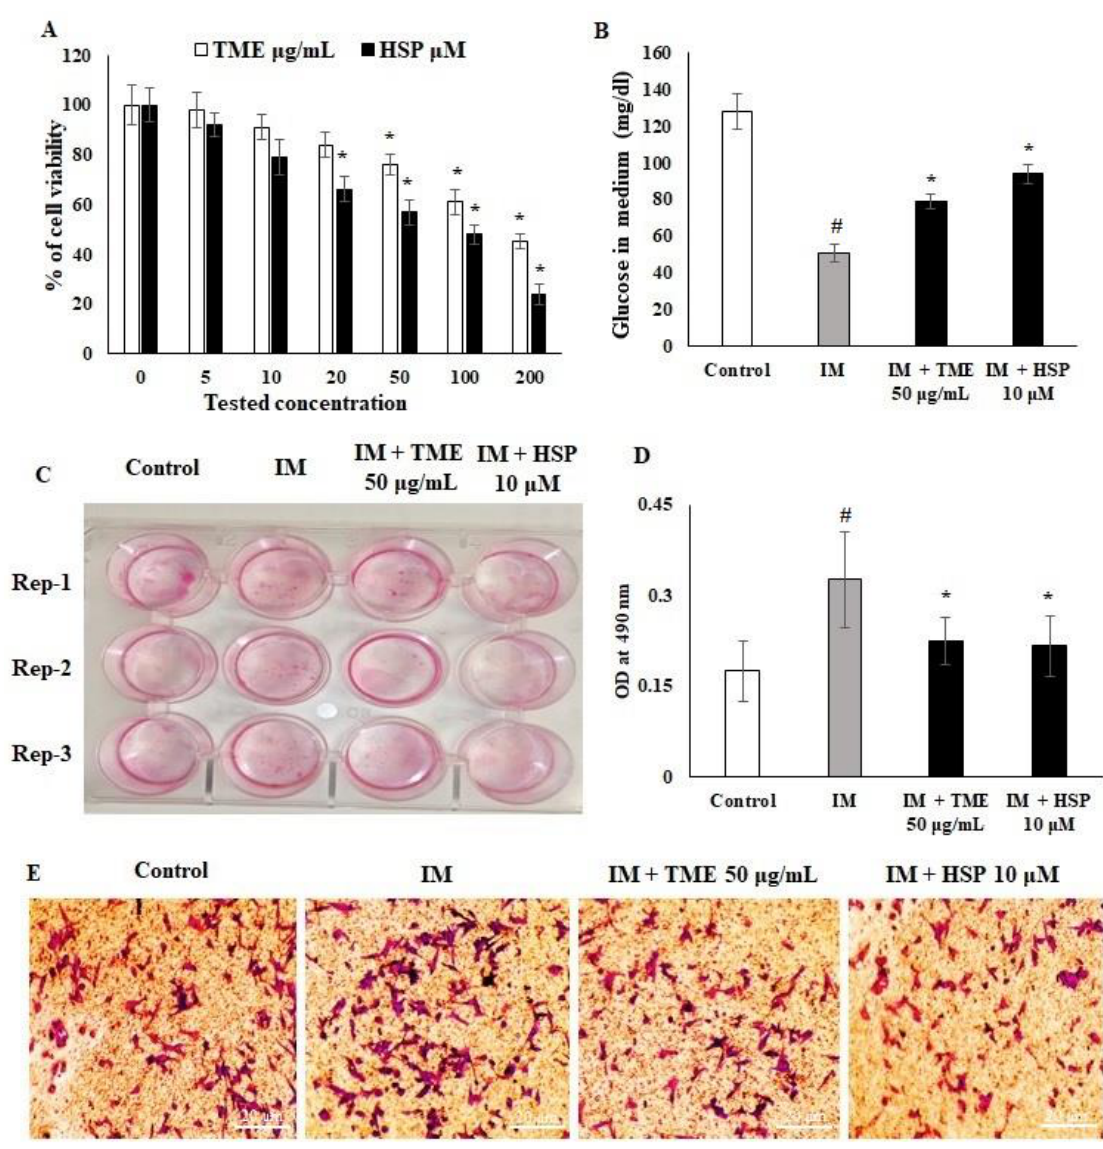
Figure 9. Effect of TME and HSP on 3T3-L1 cell line. ( A ) Cell viability. ( B ) Glucose uptake. ( C – E ) Oil Red O staining on day 8 of culture; OD values were measured at 490 nm. The experimental data are shown as mean ± SD of triplicate values; * significant difference from the IM group. # significant difference between IM and control groups. TME; total methanol extract, HSP; hesperidin, IM; induction medium .